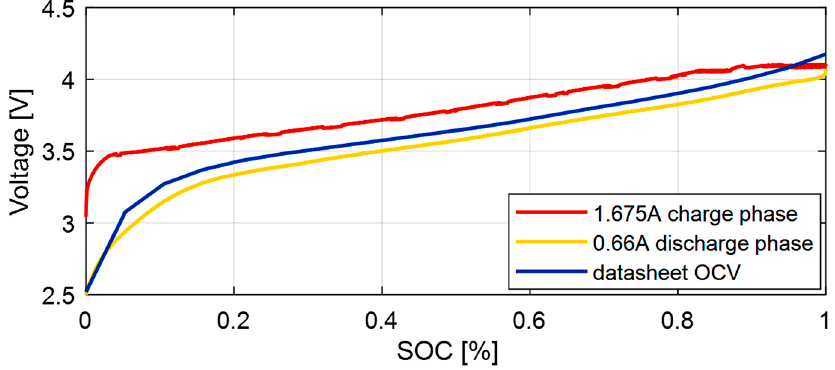
Figure 7. OCV and closed-circuit voltage (CCV) across SOC in charge and discharge phases. The OCV from the datasheet is between the measured terminal voltage in charge and discharge phases. The middle blue curve shows the OCV as a function of SOC, as acquired from the datasheet. The red curve is the closed-circuit voltage at a constant charge load of 1.675 A. The yellow curve is the closed-circuit voltage at a constant discharge load of 0.66 A. It can be seen that the OCV taken from the datasheet approximates the true OCV at the mean of the closed-circuit voltages of the charge and discharge phases. The larger deviation of the charge phase results from the relative higher load with respect to the discharge phase.